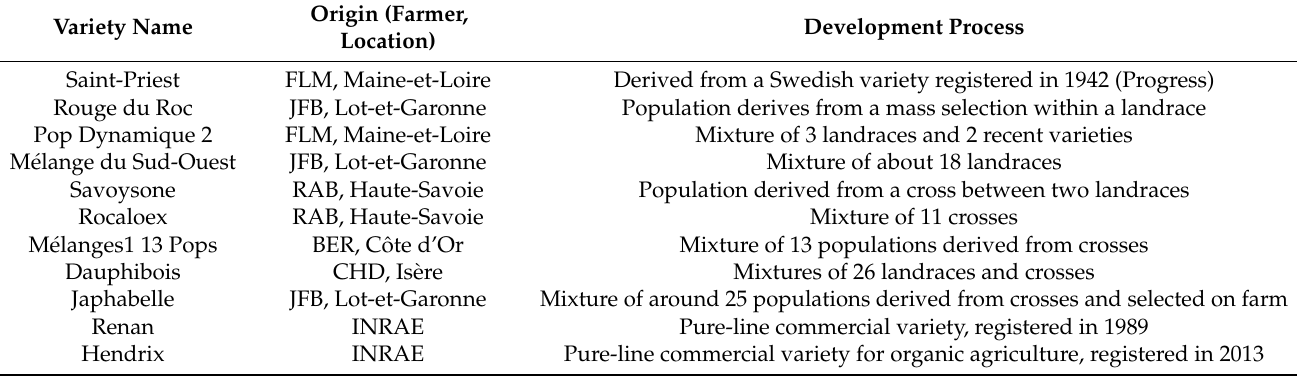
Table 1. Description of the origin and development process of the participatory plant-breeding (PPB) populations and commercial varieties studied.